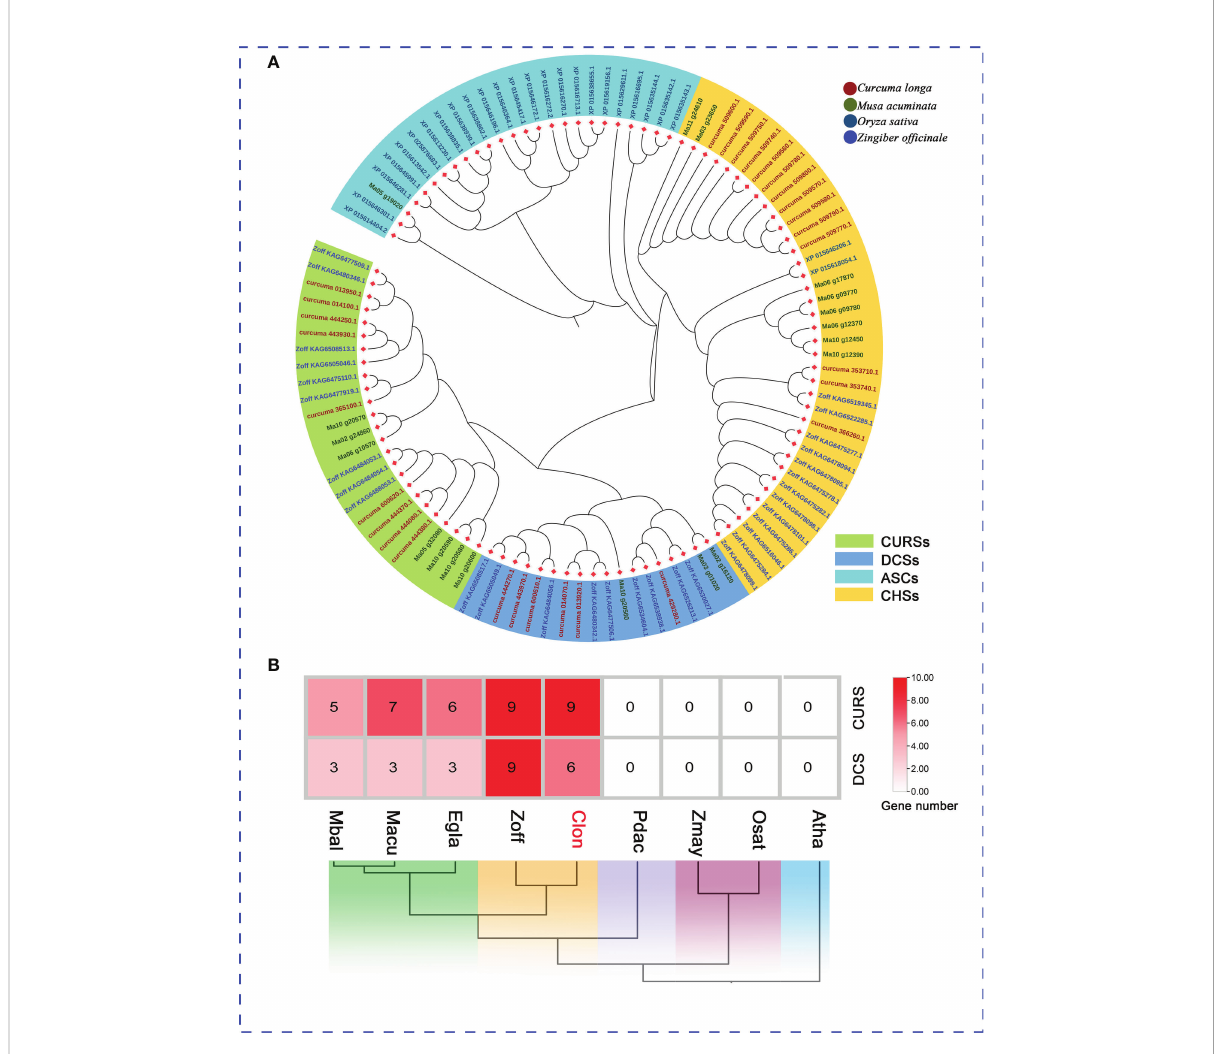
FIGURE 6 The PKS Genes Clusters Identi fi ed in the C. longa Genome. (A) Phylogenetic analysis of PKS genes from C. longa , Z. of fi cinale , M. acuminate and O. sative . Different colored boxes represent the classi fi cation of PKSs. (B) Distribution pattern of the expanded gene families in curcumin biosynthesis pathway and comparison with other species.